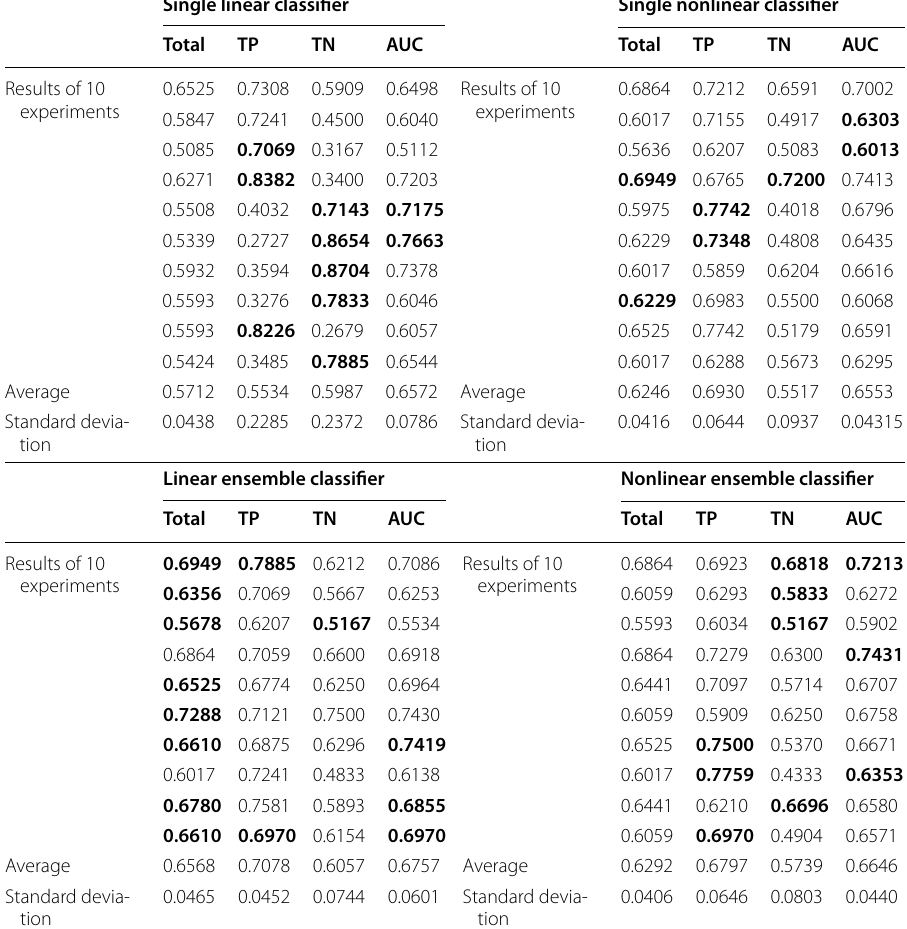
Table 8 Robustness analysis of classification without feature extraction in China Unionpay dataset when feature dimensions sample ≥